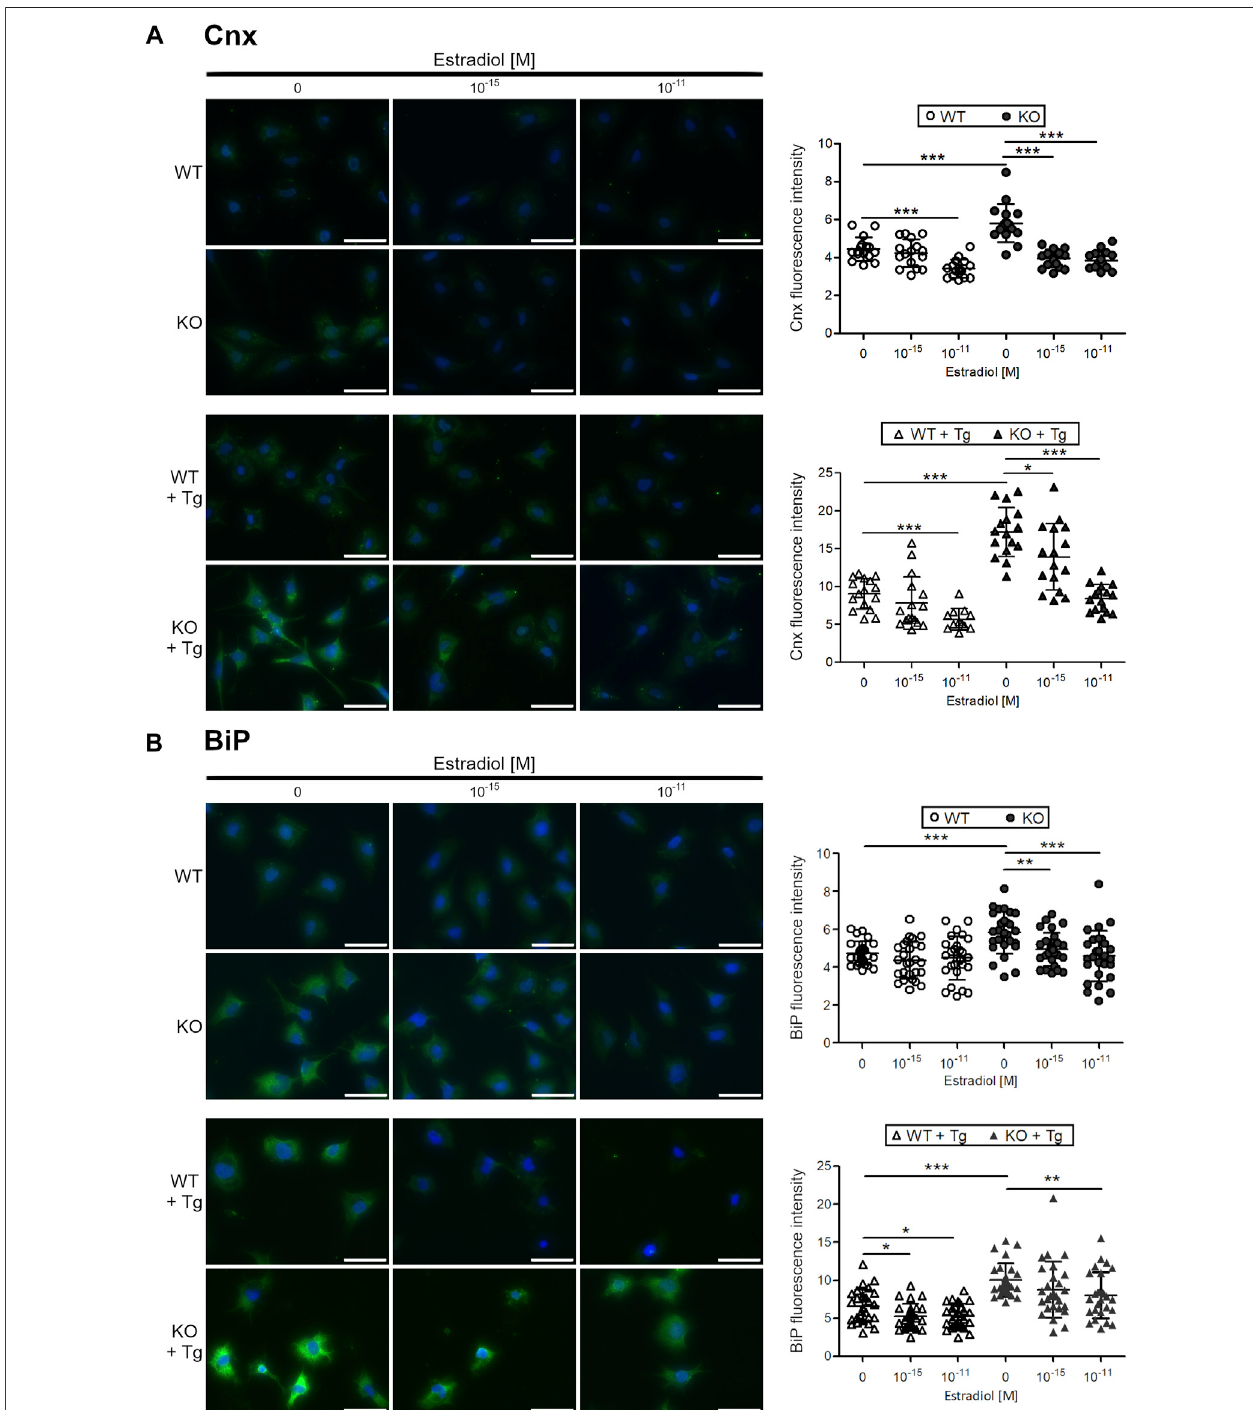
FIGURE 1 | Estradiol reduces the protein expression of ER stress markers calnexin and BiP in C28/I2 WT and ERp57 KO chondrocytes in vitro . C28/I2 WT and ERp57 KO chondrocytes were cultured for 48 h in presence or absence of 1 µM of the ER stress inductor thapsigargin (Tg) with 0, 10 – 15 , and 10 – 11 M estradiol. (A) Immuno fl uorescence staining of calnexin (Cnx) revealed a reduction of fl uorescence intensity in WT cells by 10 – 11 M estradiol ( p = 0.0000095). As expected, ERp57 KO cellsshowedahigherCnxsignalintensitythanWTcells( p =0.0000724),whichwasreducedby10 – 15 M( p =0.0000002)and10 – 11 M( p =0.0000001)estradiol.In presence of thapsigargin, Cnx expression is higher in both, WT and ERp57 KO chondrocytes with KO cells displaying even higher levels of Cnx fl uorescence intensity than WT cells ( p = 0.000000002). WT cells + Tg showed a reduced Cnx expression in presence of 10 – 11 M estradiol ( p = 0.0000369). KO cells + Tg revealed a reduced